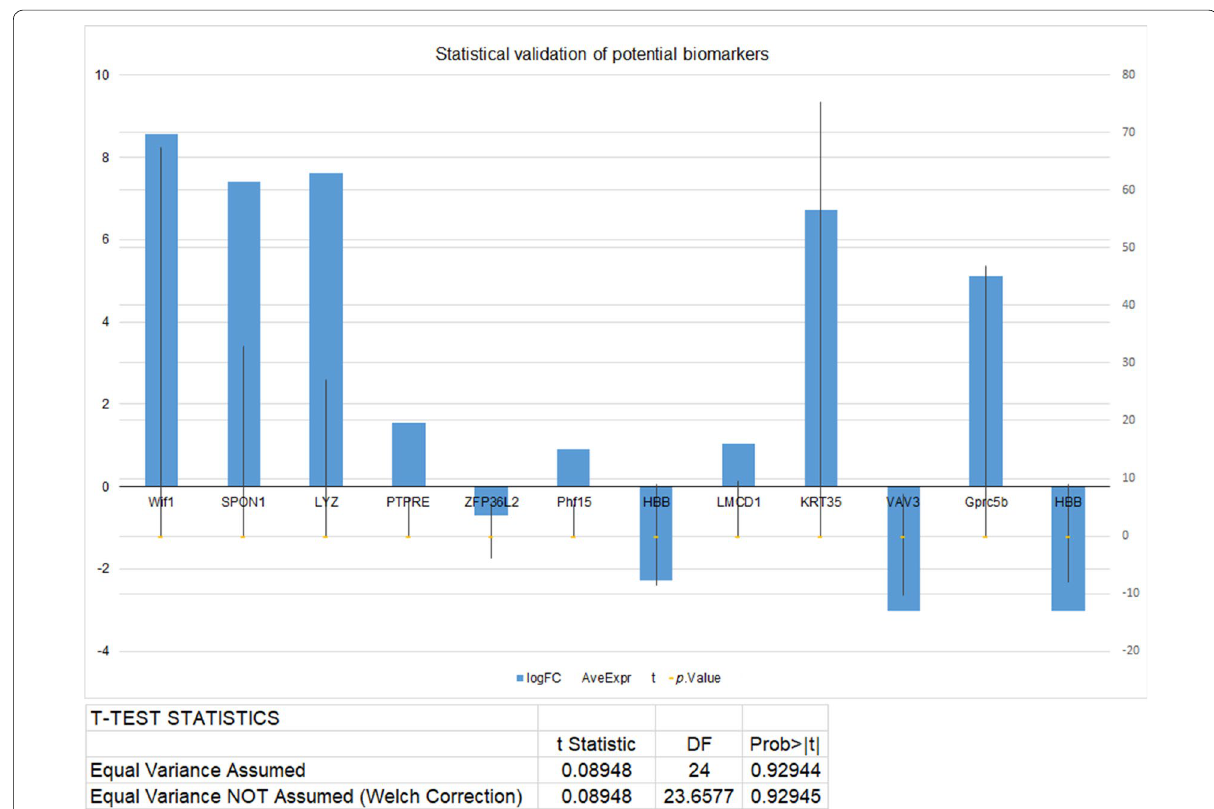
Fig. 8 Statistical validation of potential biomarkers based on logFC, AveExpr, p -value and t-test statistics (classifier